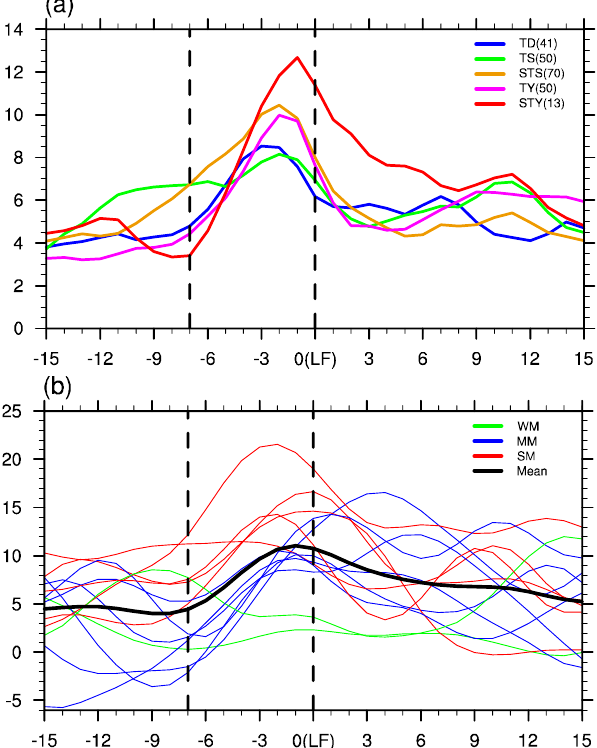
Figure 2. Time series of the WNPSMI fifteen days before (negative) and after (positive) TCs making landfall (LF) in SC. ( a ) The averaged WNPSMI for each type of landfall TCs. ( b ) The WNPSMI for each LSTYs and their mean values (black line), calculated by wind fields without TC circulation. The vertical dash lines indicate the landfall day and seven days ( − 7) prior to LF, respectively. Label legends in ( a ) indicate the landfall intensity in SC with the corresponding numbers of TCs in